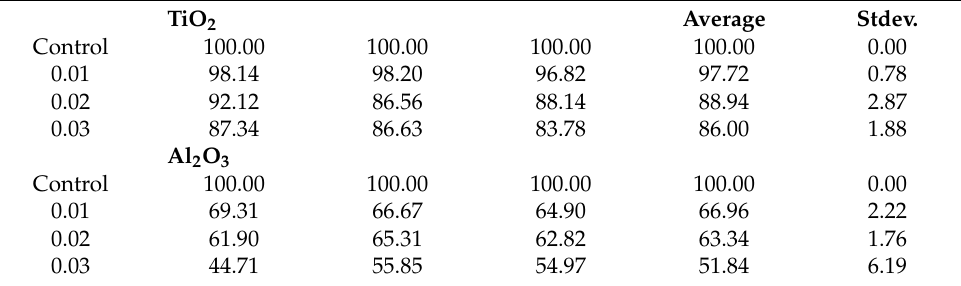
Table 1. MTT assay for survivability: 0.01%, 0.02%, and 0.03% Nano- TiO 2 and Al 2 O 3 -treated